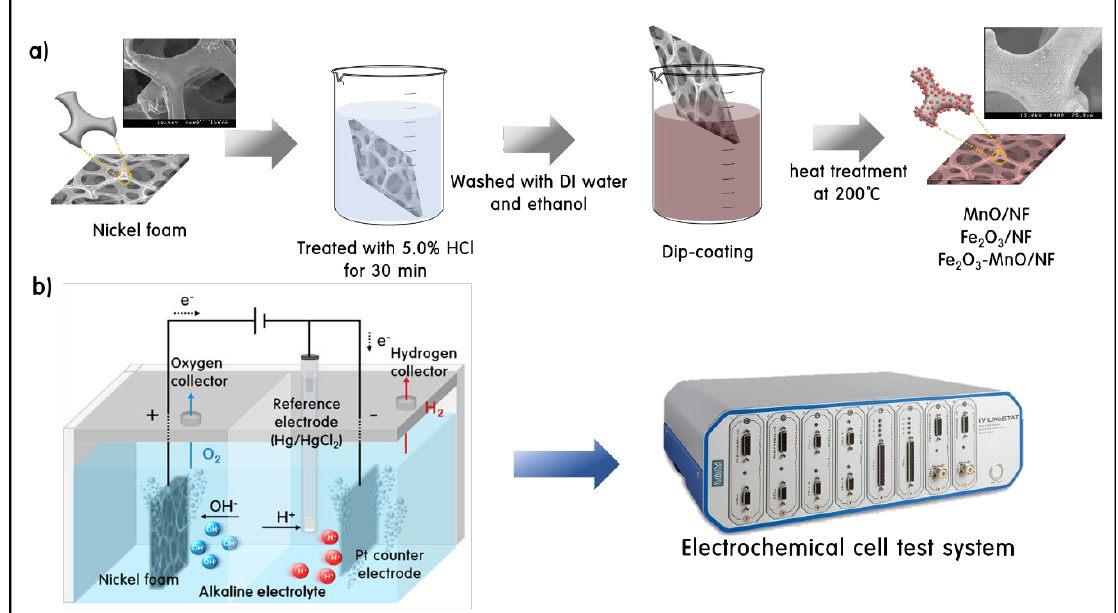
Scheme 1. Electrode fabrication sequence ( a ) and electrochemical device image for oxygen evolution reaction (OER) test ( b